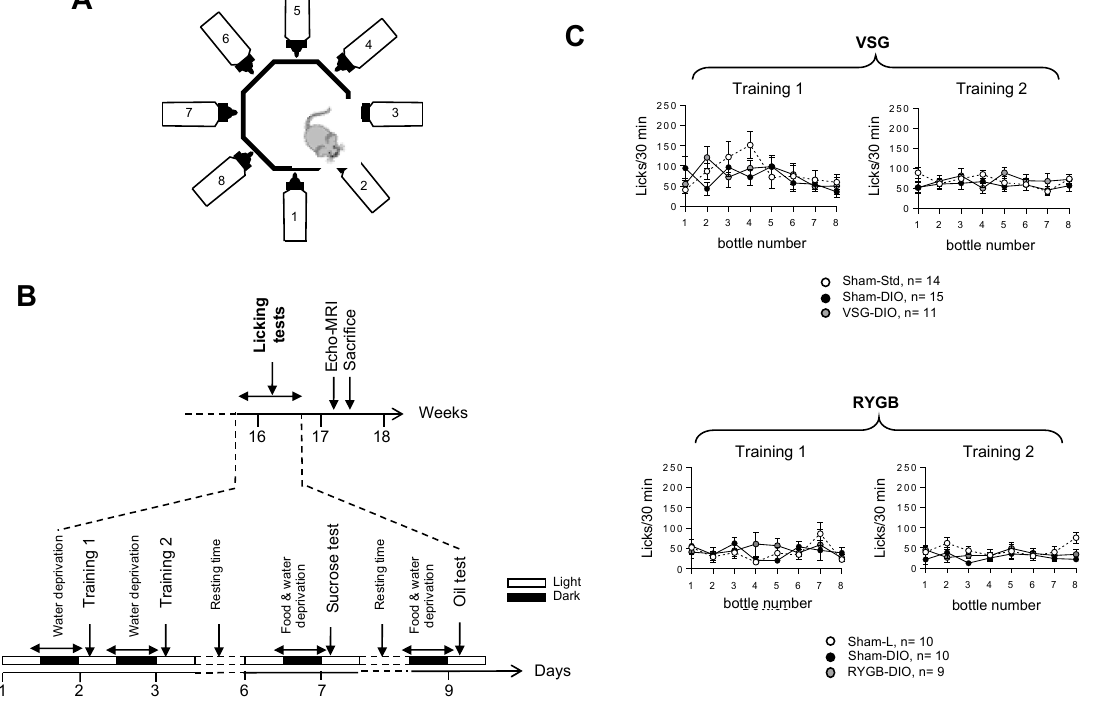
Figure 2. Analysis of the licking behavior in sham-operated lean (Sham-L) and obese (Sham-DIO) controls and in obese mice that underwent a vertical sleeve gastrectomy (VSG-DIO) or a Roux-en-Y gastric bypass (RYGB-DIO) during the training sessions. ( A ) Design of the gustometer. ( B ) Time- course of licking tests session. ( C ) Analysis number of licks per bottle during the training sessions (30 min). Training 1: mice have free access to the eight bottles filled with water. Training 2: mice are subjected to random and intermittent access (10 s) to each of the eight bottles filled with water. Mean ± SEM, Wilcoxon and Mann–Whitney tests. DIO—diet-induced obesity.